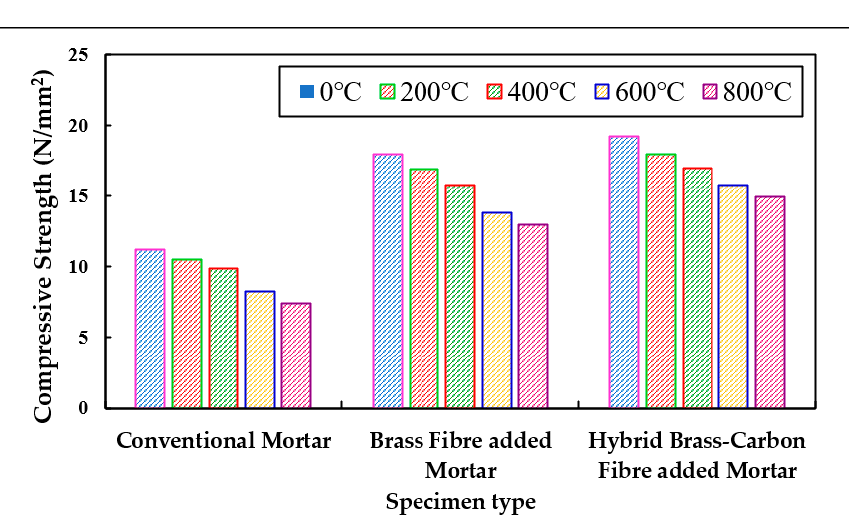
Figure 14. Graphical illustration of compressive strength values of conventional mortar cube sub- jected to elevated temperatures.